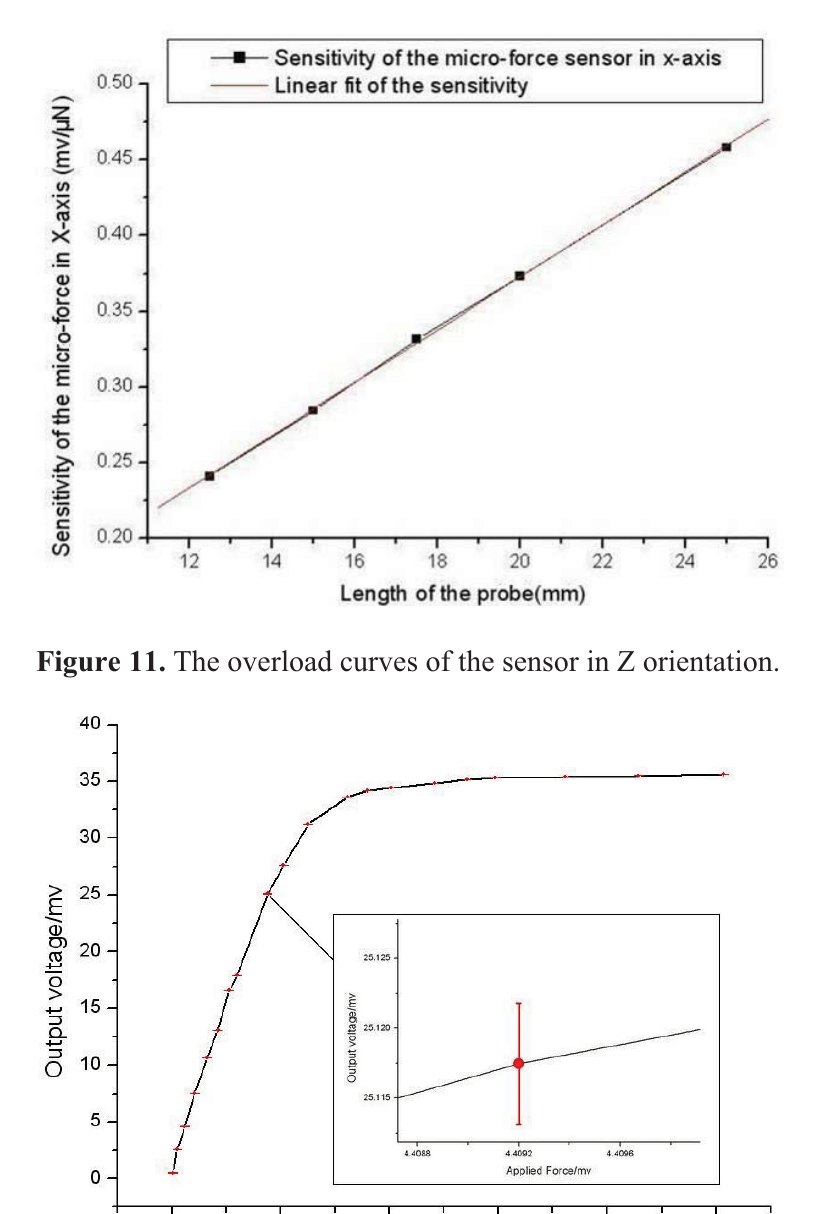
Figure 10. The sensitivity of the micro-force sensor in X-axis versus the length of the probe.